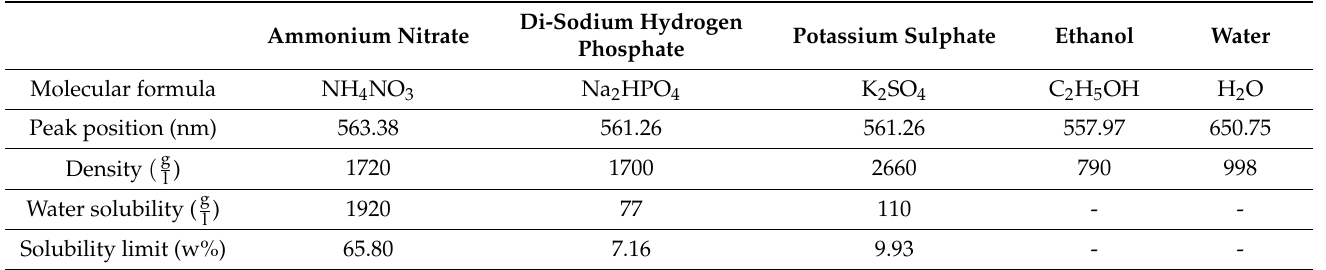
Table 2. Substance specifications of ammonium nitrate, di-sodium hydrogen phosphate, potassium sulphate, and ethanol.